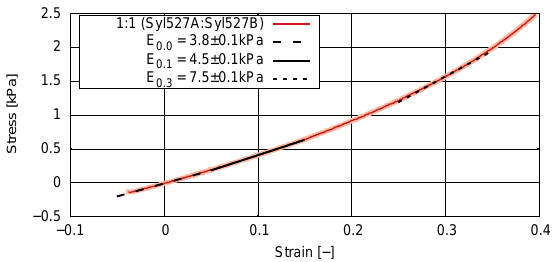
Figure 6. Deformation behaviour of 1.0 to 1.0 (Syl- gard 527A to Sylgard 527B)